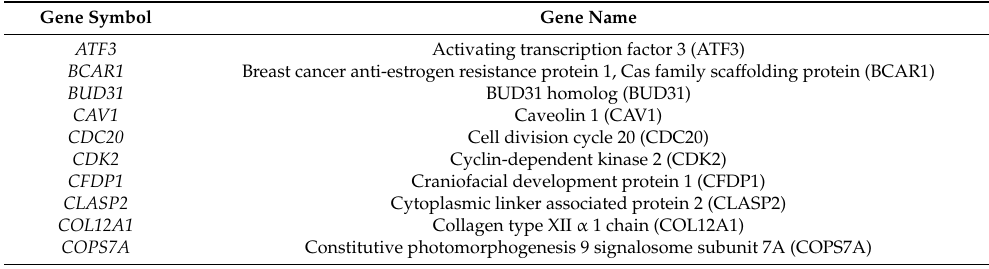
Figure 2. Venn diagram displaying interacting genes between estrogenic endocrine disruptors (EED) (polychlorinated biphenyls (PCBs) and bisphenol A (BPA)), ID1 ‐ 4, and neurocognitive disorders. Results show 63 overlapping genes [65,71]. Table 1. Gene symbols and gene names of 63 overlapping EED ‐ Inhibitor of Differentiation (ID) protein ‐ neurocognitive genes.